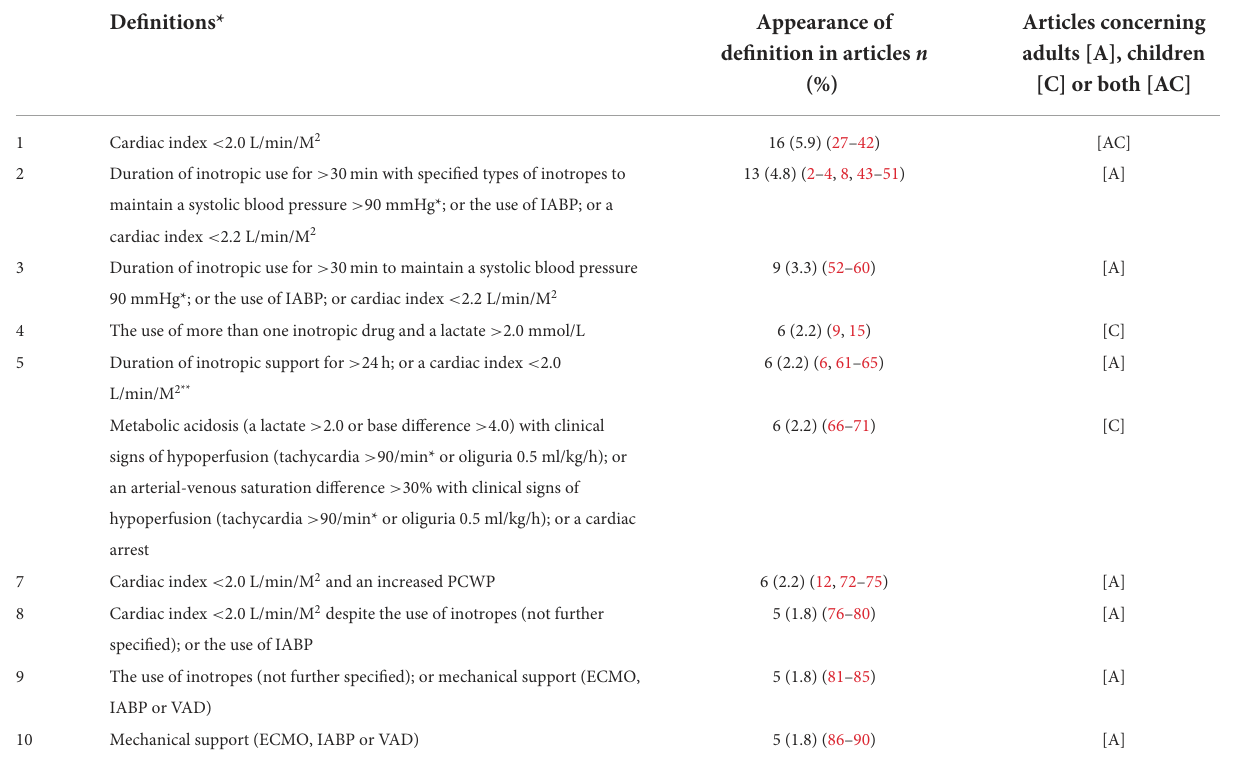
TABLE 3 Top 10 most published definitions of low cardiac output